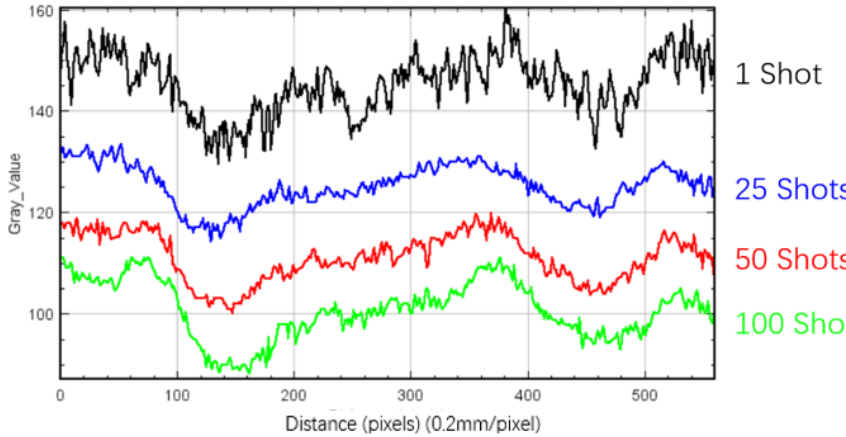
Figure 31. Denoising effects by stacking 1, 25, 50, and 100 X-ray shots. Table 5. Gray value numbers and K ratios of Figure 33. 750 mm by 3.95 MeV, grout is not